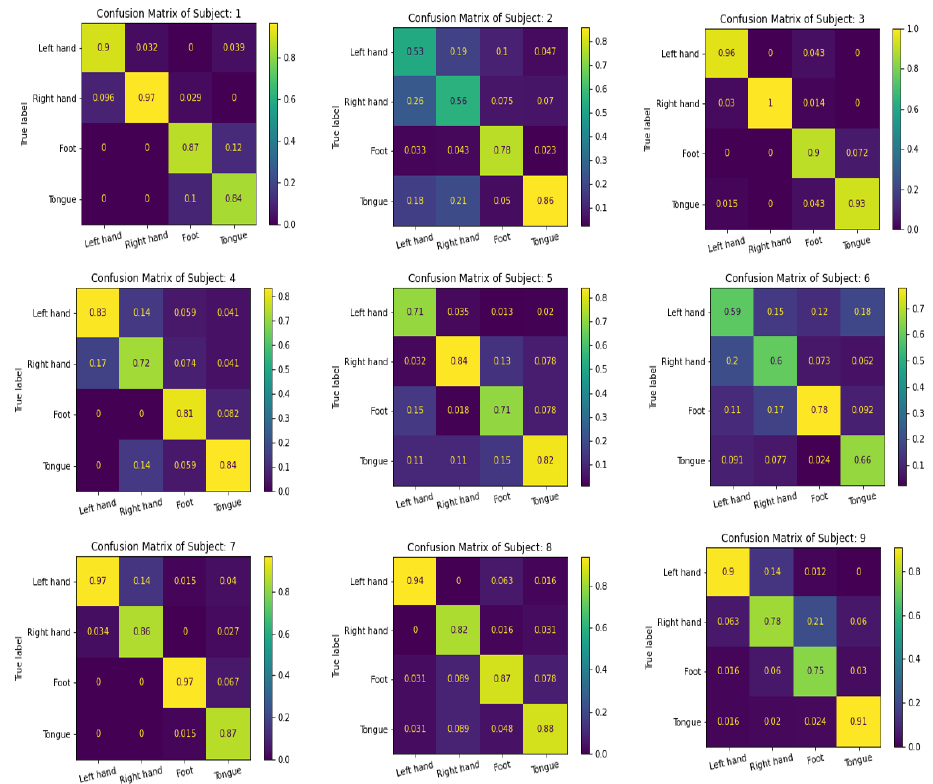
Figure 8. The confusion matrixes of MBEEGNet on the MI BCI IV-2a dataset.